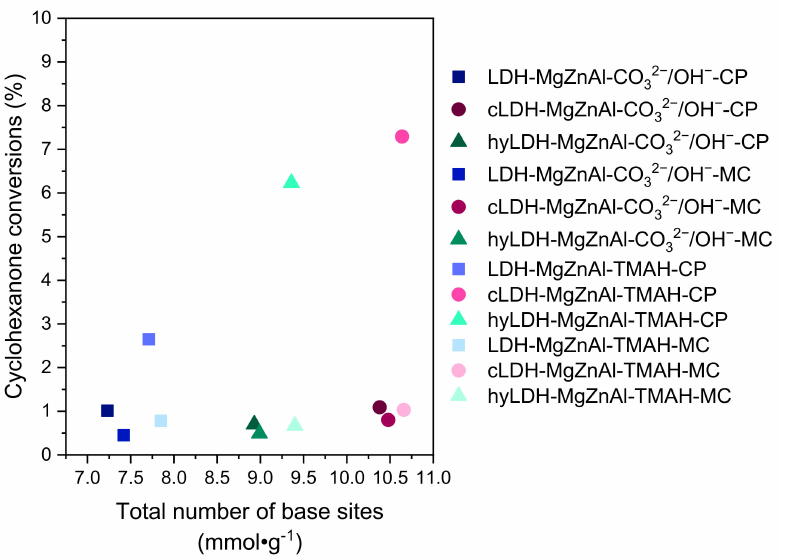
Figure 7. Cyclohexanone conversion vs. total number of base sites of investigated catalysts in self-cyclohexanone